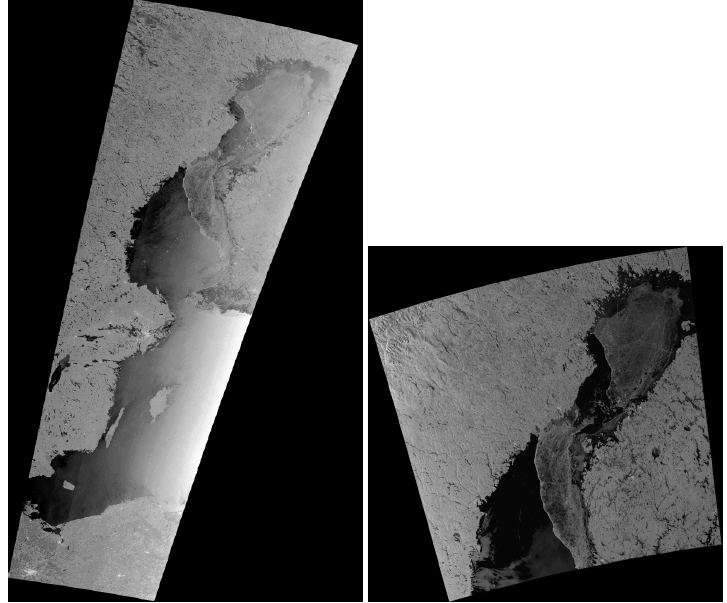
Fig. 3. SAR images from 3 April 2011 at 09:17:34UTC (Envisat ASAR, ©ESA, left) and 3 April 2011 at 16:12:42UTC (Radarsat-2, ©MDA, right) over the Gulf of